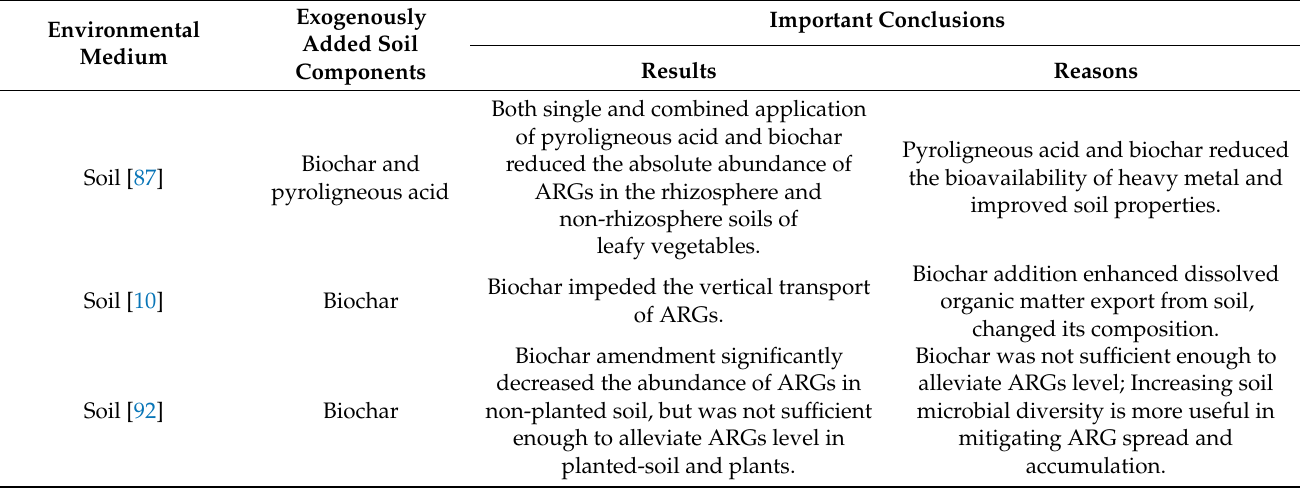
Table 3. Research on the effects of externally adding soil components to antibiotic resistance genes